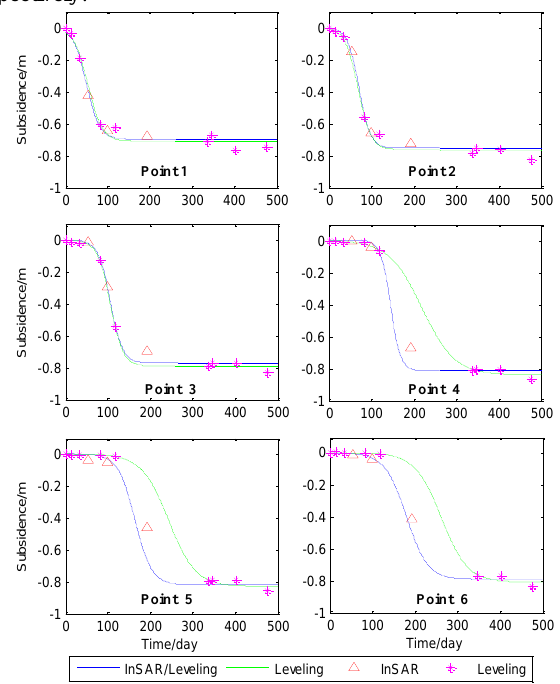
Figure 4. Logistic function fitted by fusing InSAR and leveling measurements (blue line) and that only by leveling measurements (green